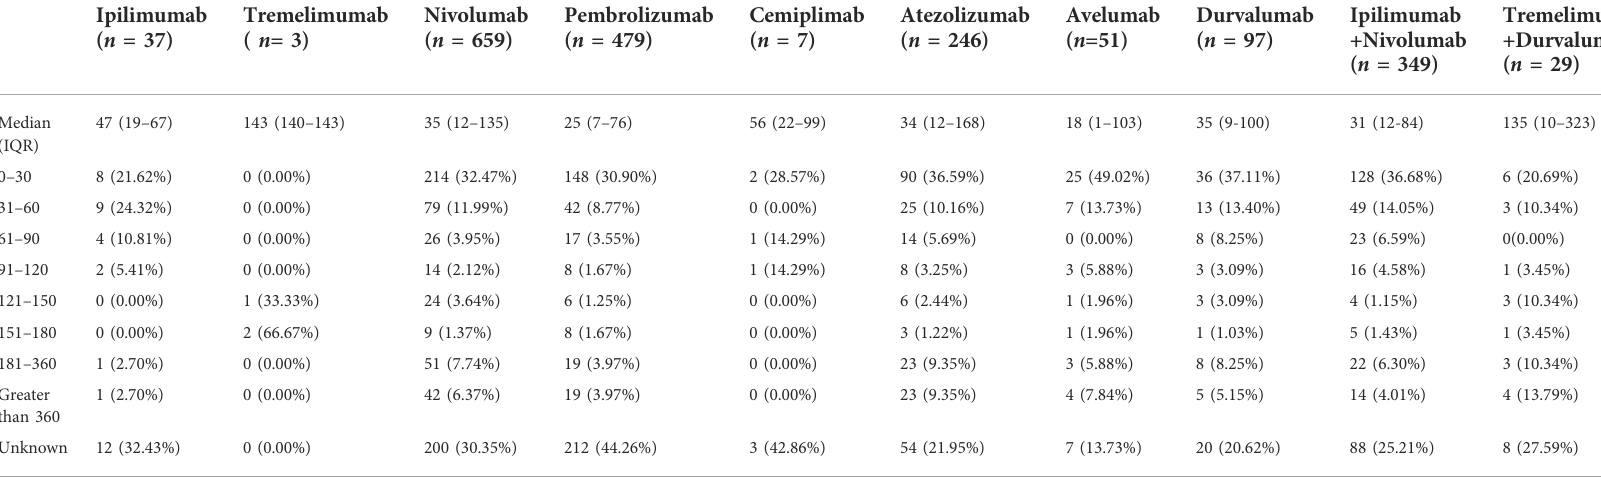
TABLE 4 Onset time of ICIs – associated